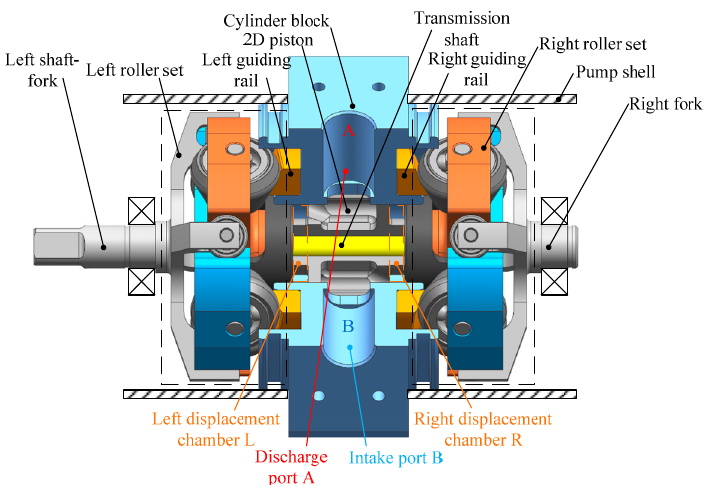
Figure 2. Mechanical structure of the high ‐ speed 2D piston pump [17].